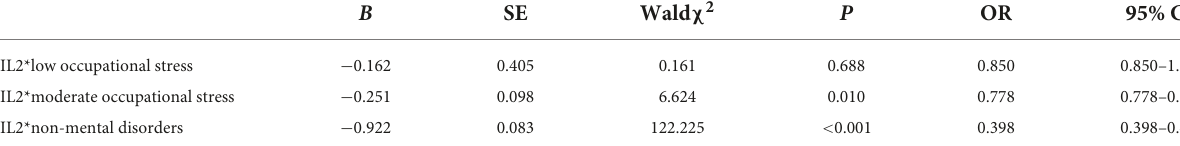
TABLE 7 Effects of occupational stress, psychological health and cytokine interactions on sleep in oil workers.